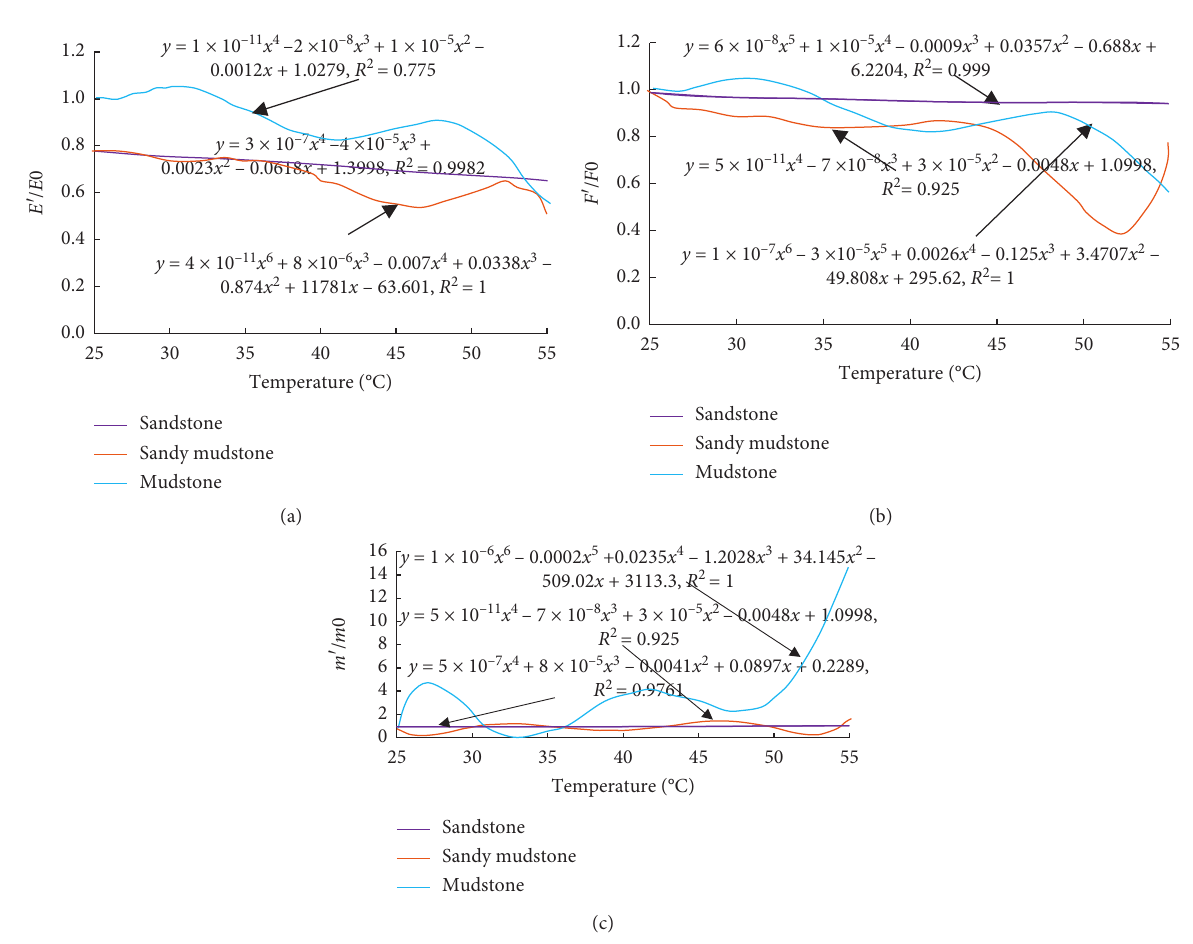
Figure 6: The curves of (a) E’ / E 0 , (b) F’ / F 0 , and (c) m’ / m 0 with